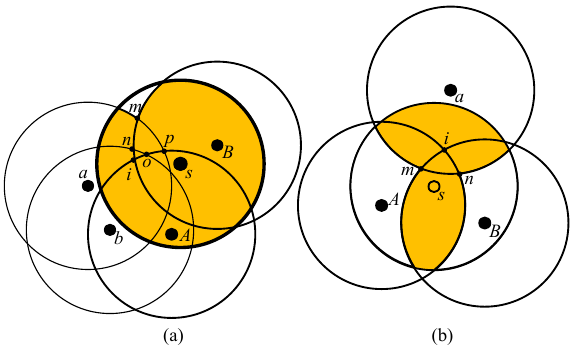
Figure 9. ( a ) The Candidate Intersection Point ( CIP ) denoted as i of sensor s is covered by candidate R − 2 R NBs a and b . ( b ) The points m and n surrounds the lower coverage regions of s